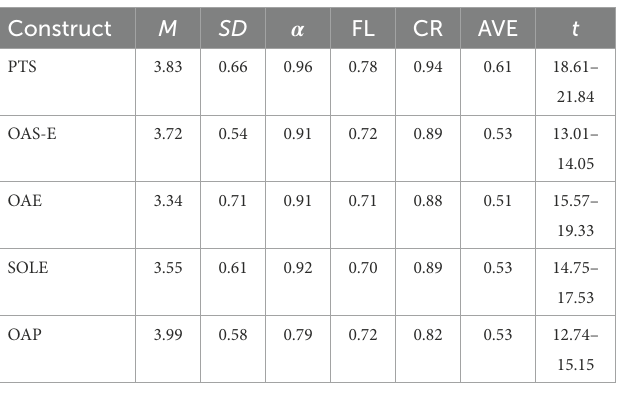
TABLE 3 Reliability and validity analysis.